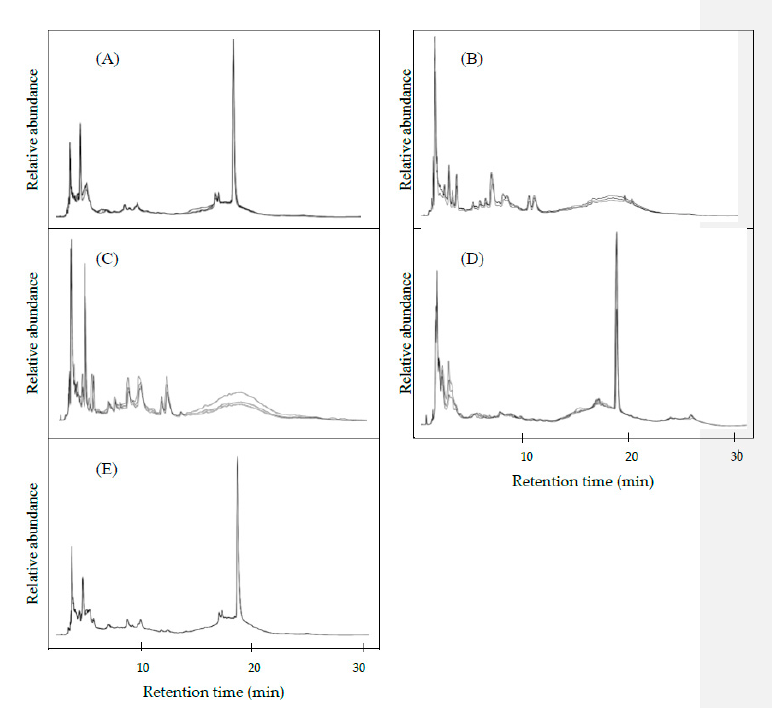
Figure 2. HPLC chromatograms (overlap of three) of ( A ) coffee beans, ( B ) soybeans, ( C ) green mung beans, ( D ) spent coffee grounds and ( E ) adulterated coffee beans containing 20% soybeans.